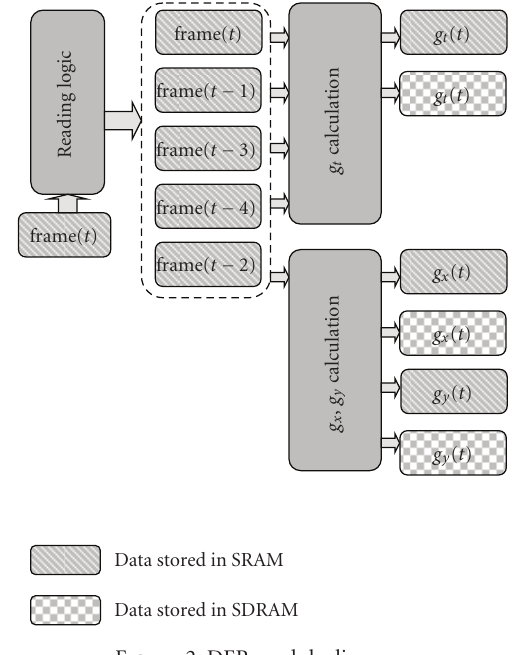
Figure 2: DER module